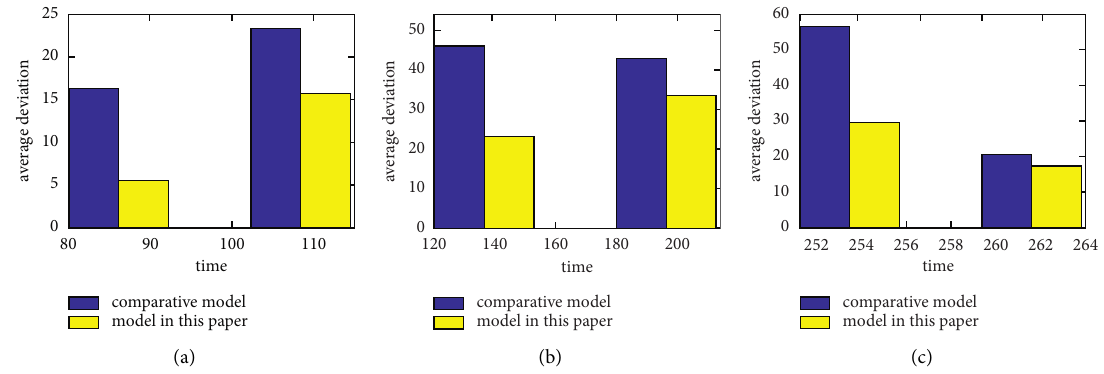
� 4 t � 7 t l . (b) t l –6 t l . (c) t l –9 t l .